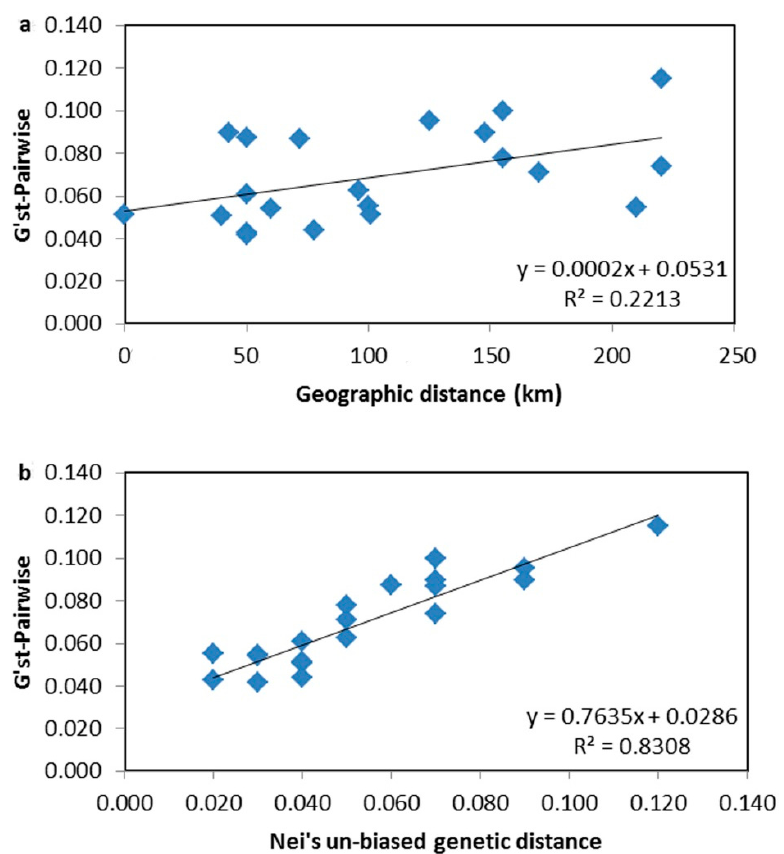
Figure 4. Mantel tests for pairwise G’ ST matrix correspondence on relationships between geographic and genetic distance for D. odorifera populations in Hainan Island. ( a ) Relationships between pairwise G’ ST and geographic distance. There is a positive relationship between the two elements (Rxy: 27.7%, p < 0.05). ( b ) Relationships between pairwise G’ ST and Nei’s unbiased genetic distance. There is a positive relationship between the two elements (Rxy: 91.2%, p < 0.05).